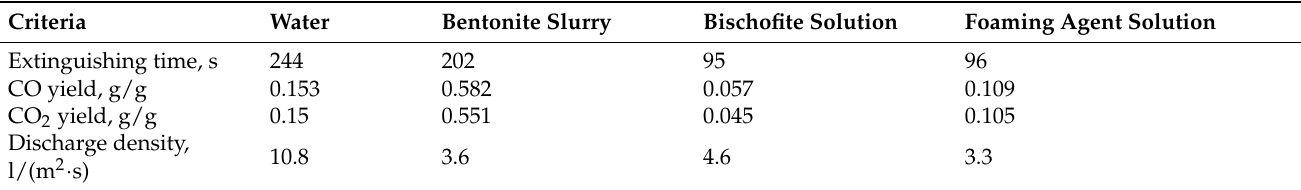
Table 8. Efficiency criteria of fire extinguishing agents.